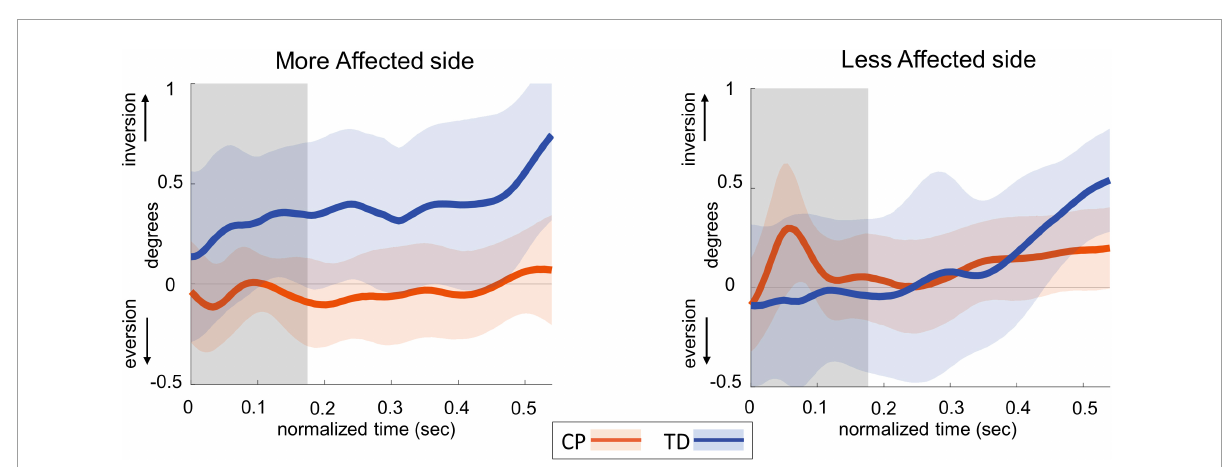
FIGURE4 Group average trajectories for subtalar angle during the first post-stimulus step following a visual fall perturbation in CP (orange) and TD (blue). Thick gray line along zero at X -axis indicates the mean of control (no fall stimulus) steps, which is subtracted from stimulus data. Shaded areas around each trajectory represent 95% confidence interval. X -axis shows 8 steps, time-normalized to 100 timepoints per steps, with double-stance (gray shading) and single-stance (no-shading). Positive and negative Y -axis indicates inversion and eversion,